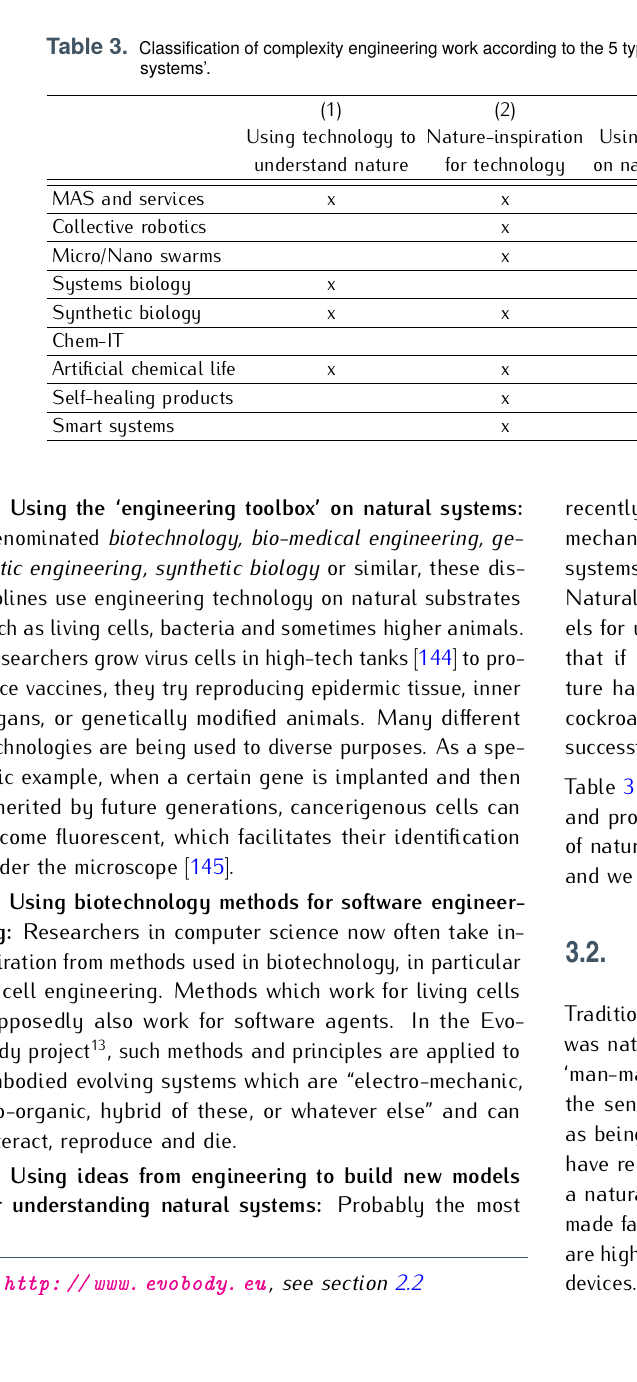
Table 3. Classification of complexity engineering work according to the 5 types of nature-inspiration. MAS stands for ‘multi-agent systems’.